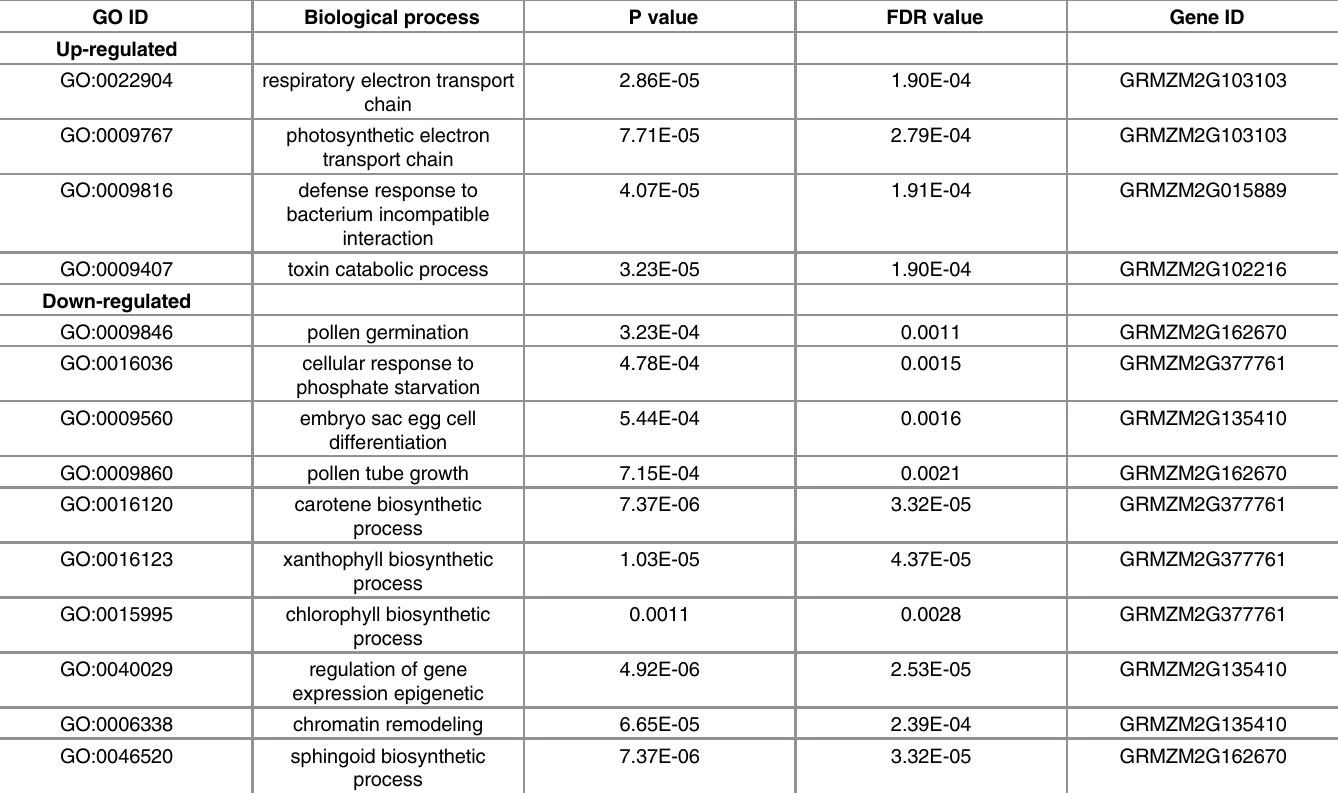
Table 2. GO enrichment analysis of specific maternal expression-level dominance genes of Ye478. GO